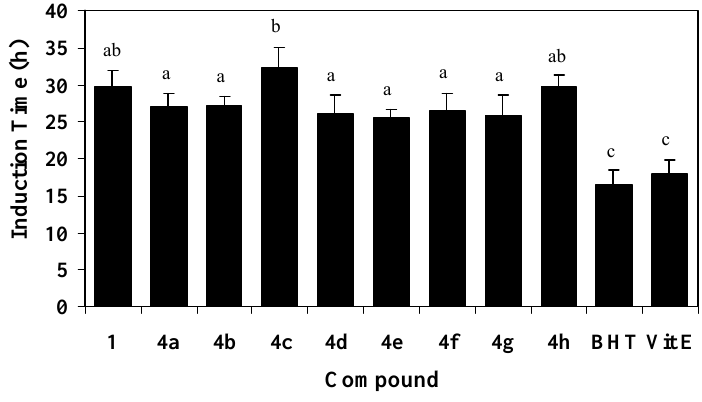
Figure 1. Oxidative stability of lipid matrices spiked with 0,5 mM of